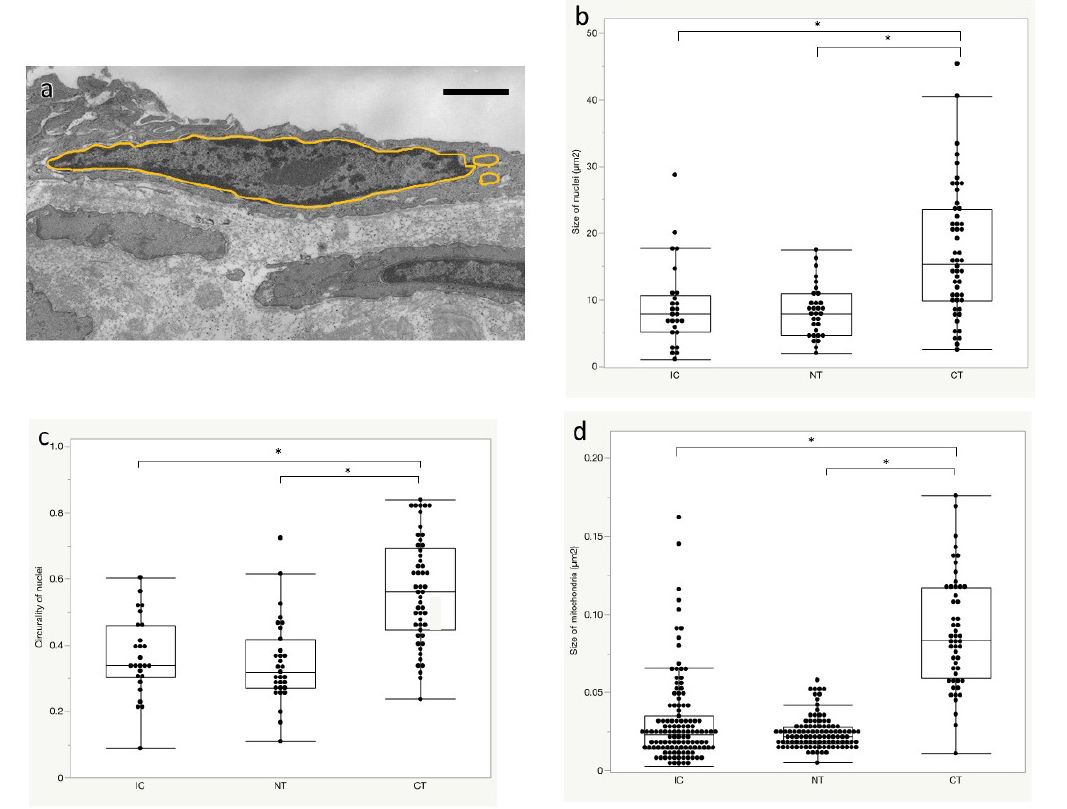
Fig. 4 - Quantitative measurements of nuclei and mitochondria in endothelial cells of the saphenous vein graft (SVG) prepared by the two different harvesting methods (no-touch [NT] and conventional [CT]) and intact control (IC). In the electron microscopy images of the IC vein, NT SVG, and CT SVG, the nuclei and mitochondria were manually segmented (a), and the size (b) and circularity (c) of the nuclei and mitochondrial sizes (d) were measured. Scale bar: 1 µm. *P < 0.05 in Steel-Dwass test. Medians with interquartile ranges and ranges of min. and max. values are